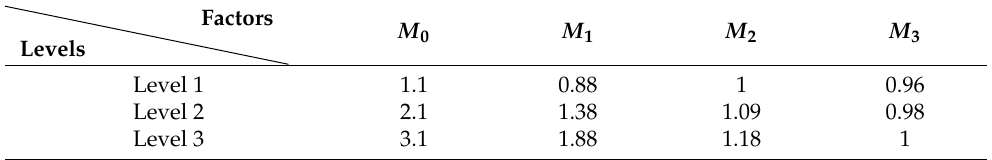
Table 3. Variables and their factor